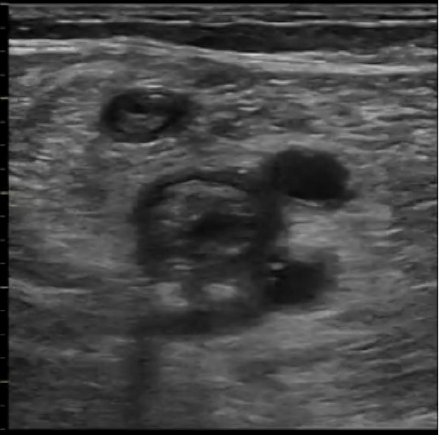
Figure 14. The image shows the presence of an extensive thrombus with mixed echogenicity occupying the lumen of the femoral vein and the great saphenous vein.